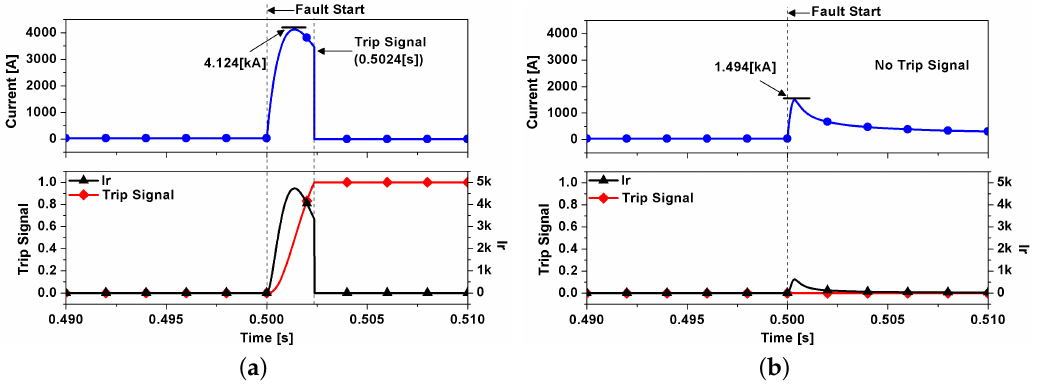
Figure 6. Fault Current and Trip Signal in Over Current Relay ( a ) W/O SFCL ( b ) With SFCL.